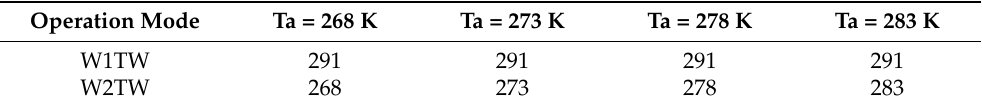
Table 5. The air temperature at the inlet under different ventilation modes in Nanjing in the winter. Operation